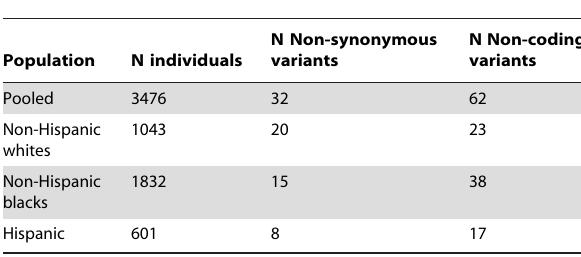
Table 1. Genetic variation in